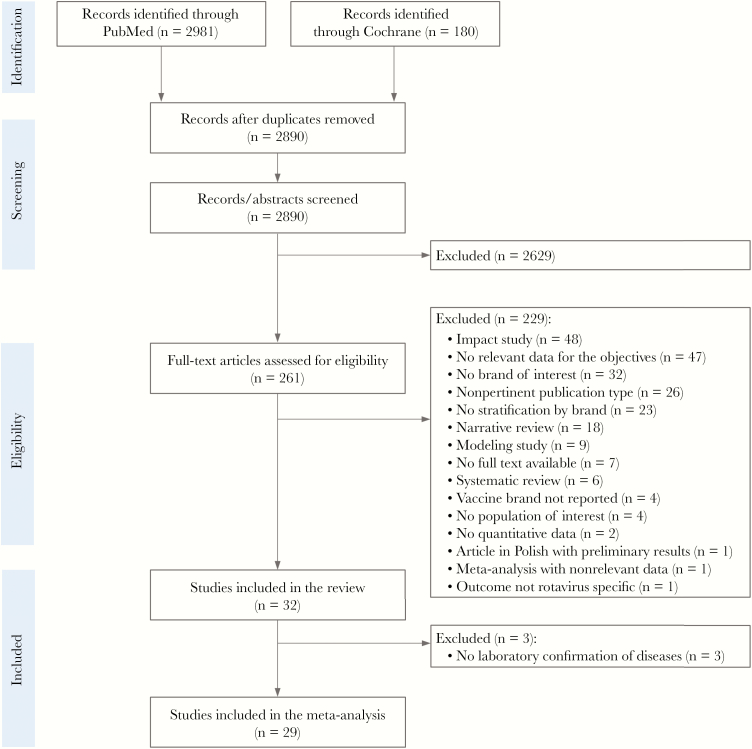
PRISMA flowchart.